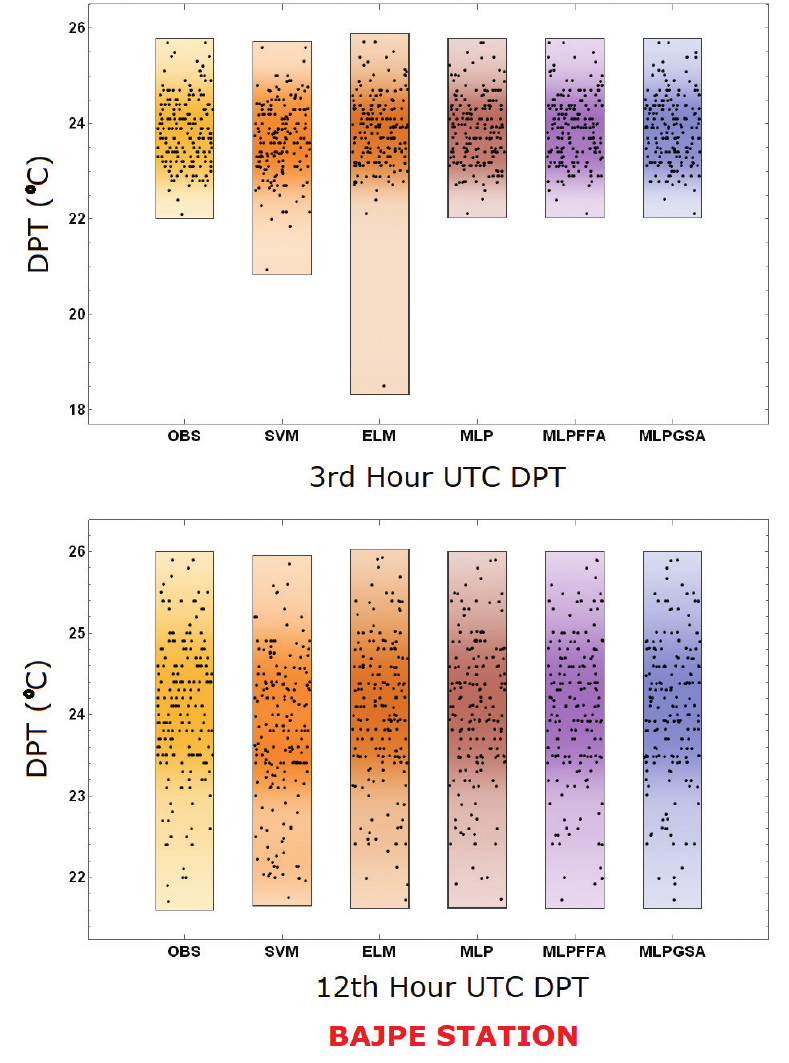
Figure 6. Point density plots of observed vs. estimated DPTs with respect to Bajpe